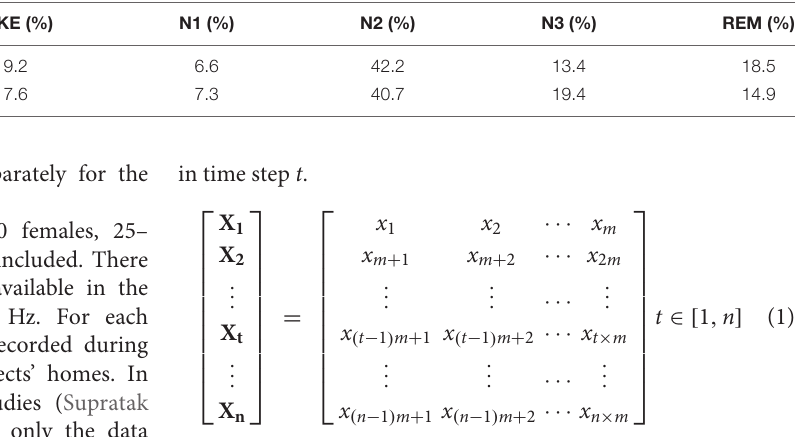
TABLE 2 | Data distribution of sleep stages in both